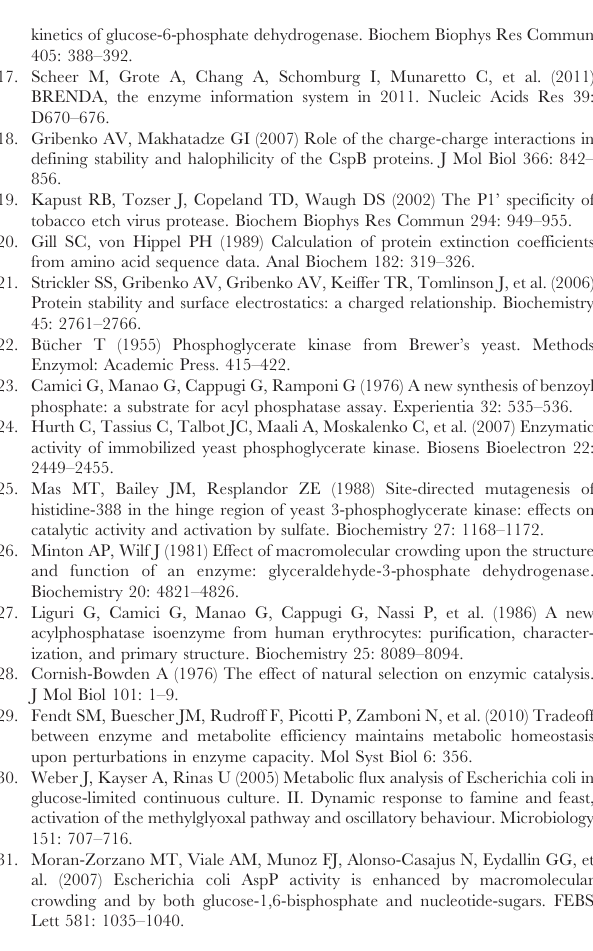
Figure S2 Michaelis-Menten plots for PGK in the reverse reaction. ( A ) Michaelis-Menten plot for PGK (5 nM) with varying concentrations of 3-PGA in the absence of Ficoll. ( B ) Michaelis-Menten plot for PGK (5 nM) with varying concentra- tions of 3-PGA in the presence of Ficoll. The black lines represent the fit to the Michaelis-Menten equation. The fit results are collated in Table 1. Figure S3 Michaelis-Menten plots for GAPDH in the forward reaction. ( A ) Michaelis-Menten plot for GAPDH (20 nM) with varying concentrations of GAP in the absence of Ficoll. ( B ) Michaelis-Menten plot for GAPDH (20 nM) with